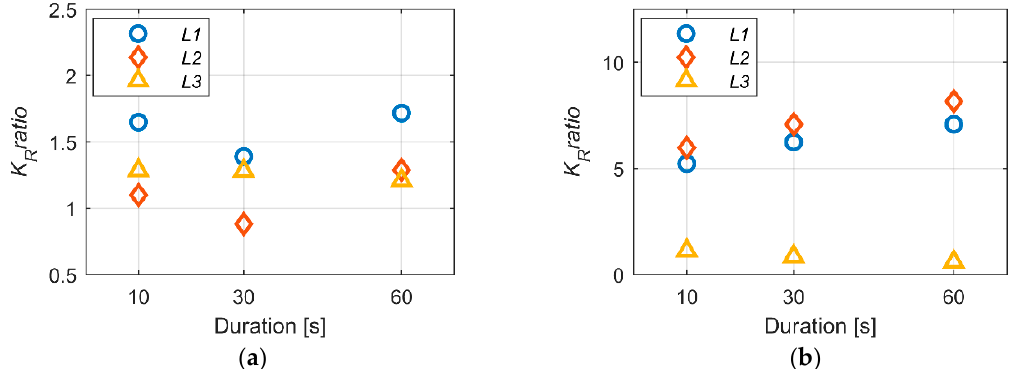
Figure 9. K R ratio as function of the acquisition duration for Ard signals: ( a ) Test-1; ( b ) Test-2.